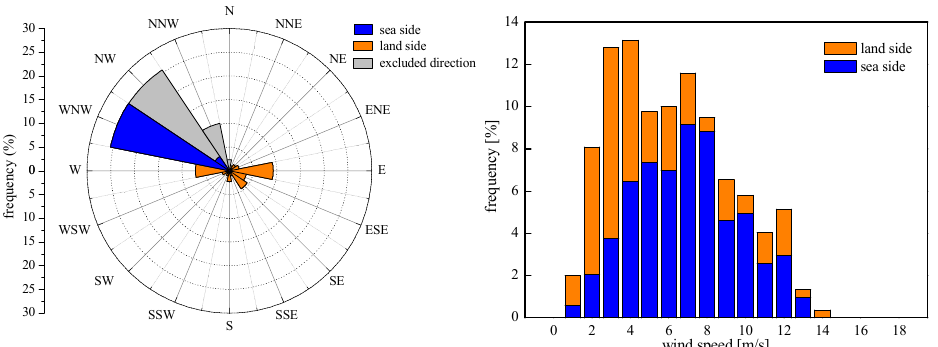
Fig. 3 Wind conditions measured at the meteorological mast (65m